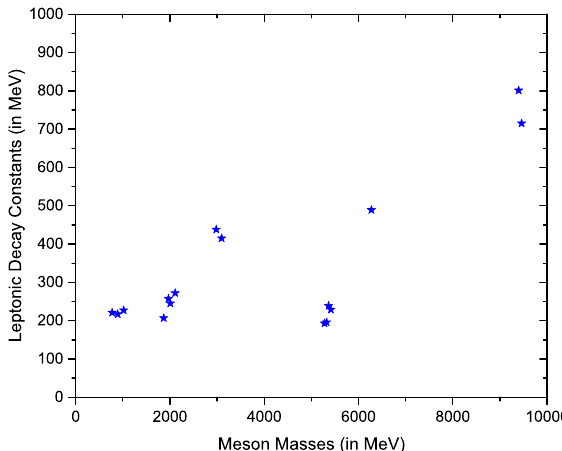
Figure 3. Experimental data on leptonic decay constants plotted versus physical masses of mesons.